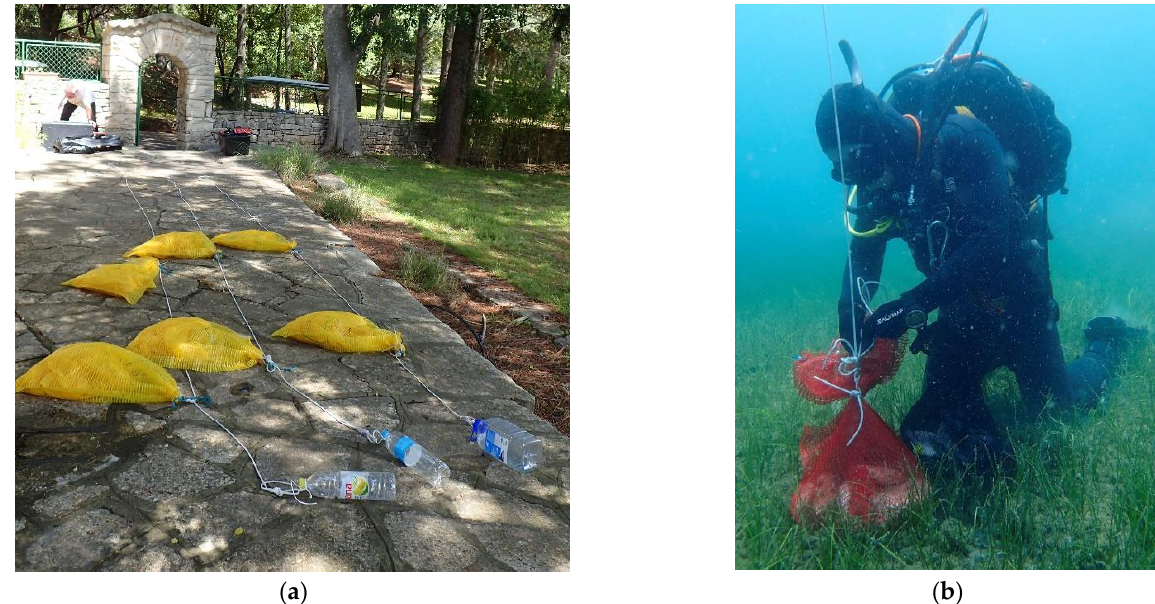
Figure 2. The collectors were assembled on land with exact distances from bag to bag (in this case, 2 m along the line from one bag to the other) (( a ), photo Tatjana Bakran-Petricioli) and then adjusted in the sea to obtain the final desired depth (( b ), photo Silvija